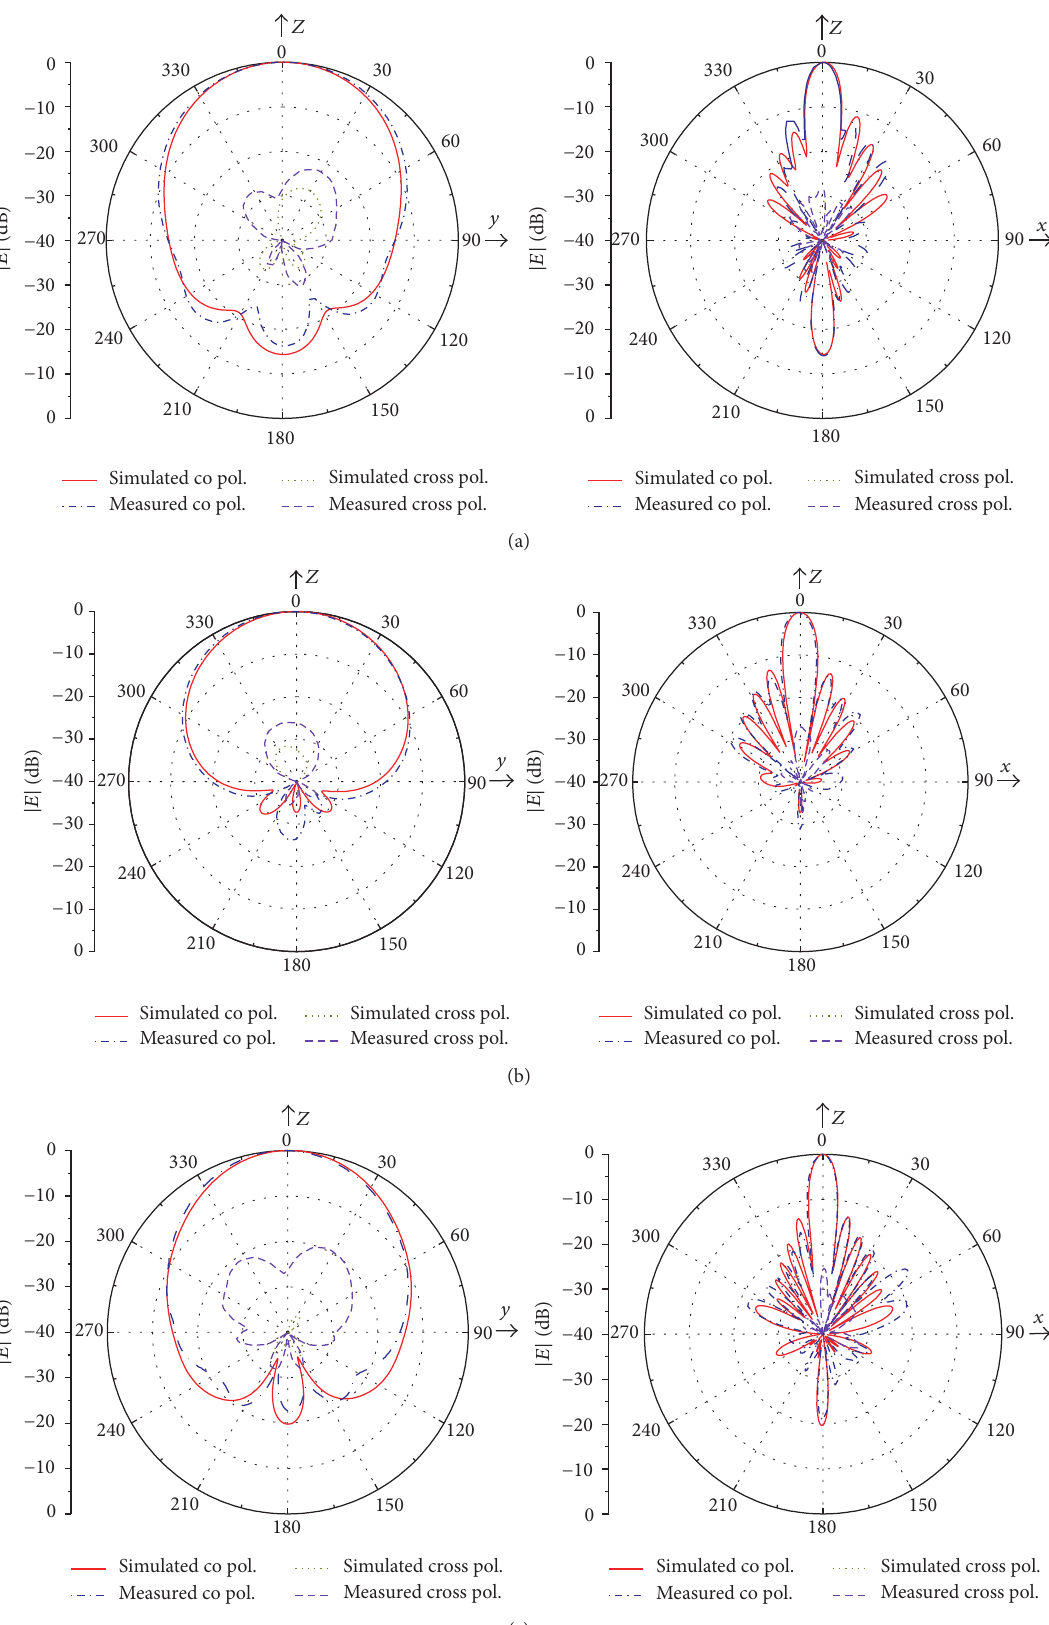
Simulated co pol. Measured co